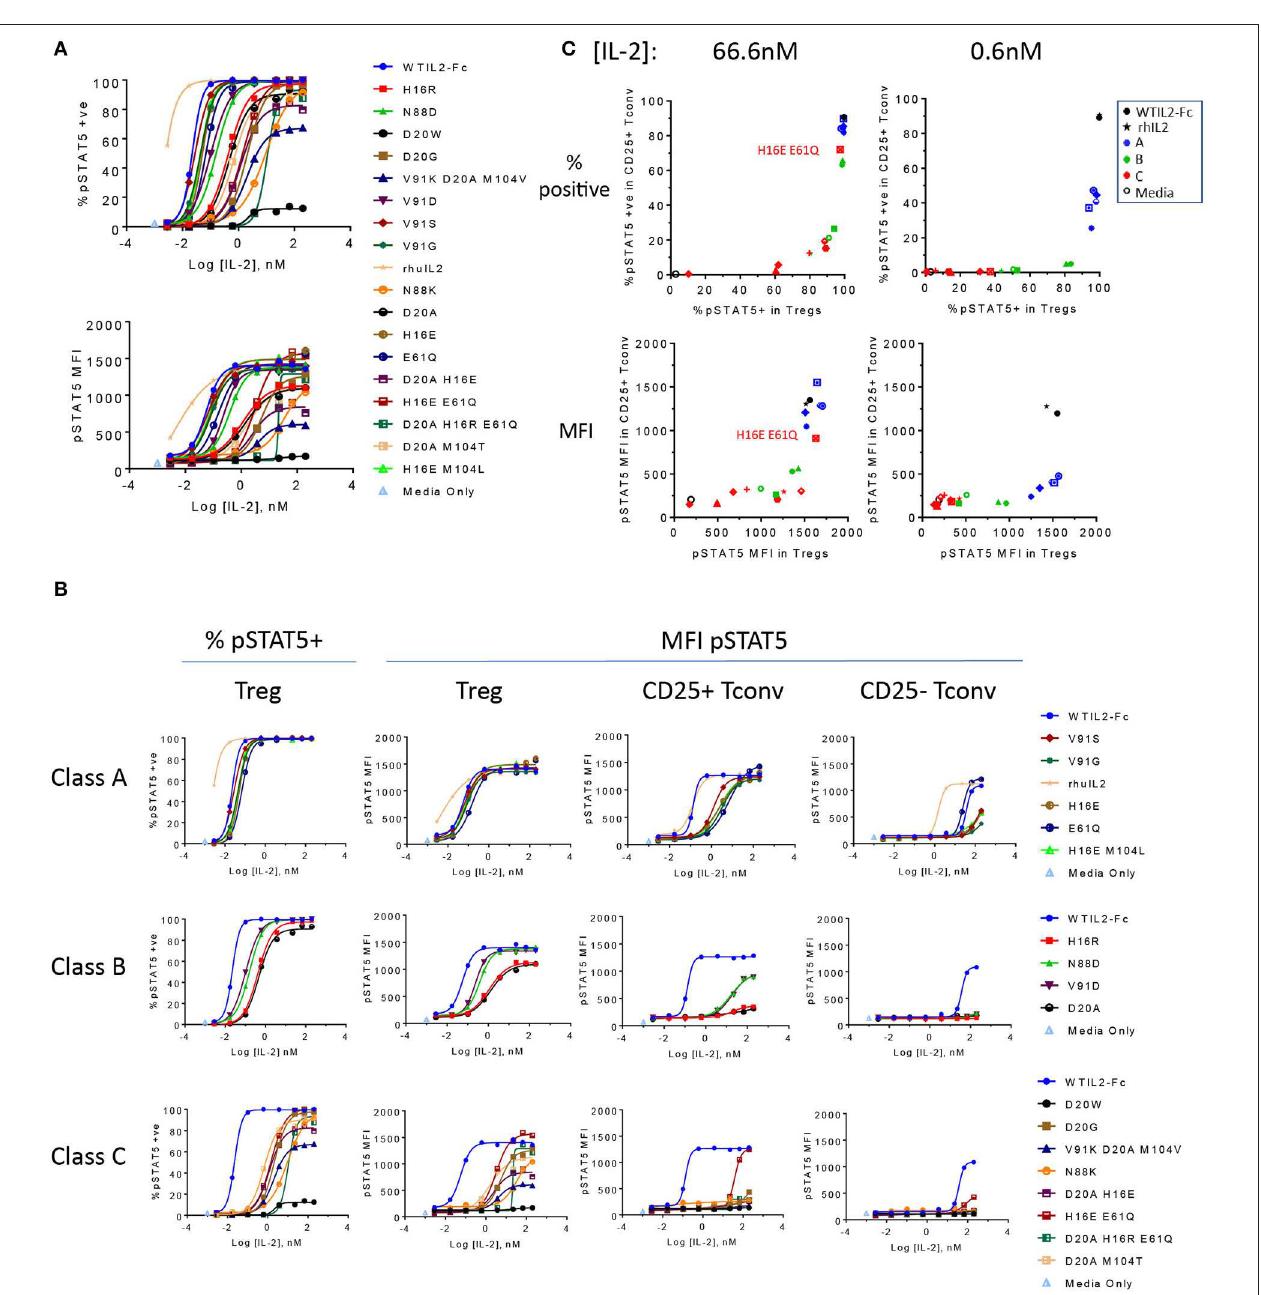
FIGURE 2 | The engineered IL-2 mutein panel induces a broad spectrum of pSTAT5 response. (A) Activity of the individual IL-2 muteins is represented by phospho STAT5 (pSTAT5) signal at increasing concentrations of IL-2 muteins in human whole blood cell assay. pSTAT5 responses are shown as both the percent (%) pSTAT5-positive cells in (top panel) and pSTAT5 MFI of (bottom panel) CD25hi Foxp3 + gated Treg cells (gating of an example plot shown in Supplementary Figure 1 ). Shown are representative plots of data from three donors. (B) The same pSTAT5 data shown in (A) are represented according to the potency-based classification to illustrate the impact of attenuation on various cell populations. Both the percent positive and pSTAT5 MFI for Treg gated populations are shown. In addition, pSTAT5 MFI data are shown for CD25 + Tconv, and CD25– Tconv cells. (C) The activity of the muteins on CD25 + Tconv cells vs. Treg cells are shown in 2D plots. Percent pSTAT5-positive and pSTAT5 MFI readouts at mutein concentrations 66.6 and 0.6nM are shown, color coded to represent wildtype IL-2 as the Fc fusion (WTIL2-Fc, black circle), free recombinant cytokine (rhIL2, black star), class A (blue), B (green), C (red) muteins, and media only control (black open circle).